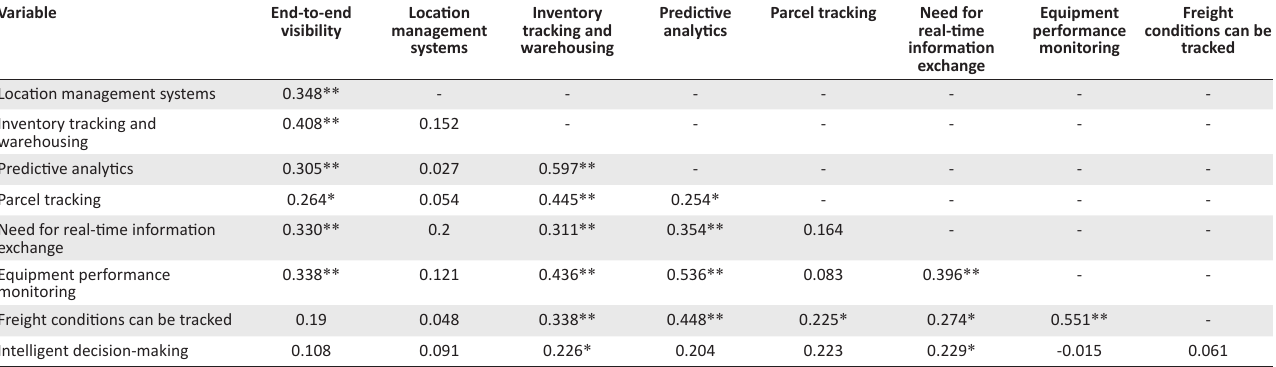
TABLE 3: Correlations: Intelligent decision-making and drivers of internet of things.